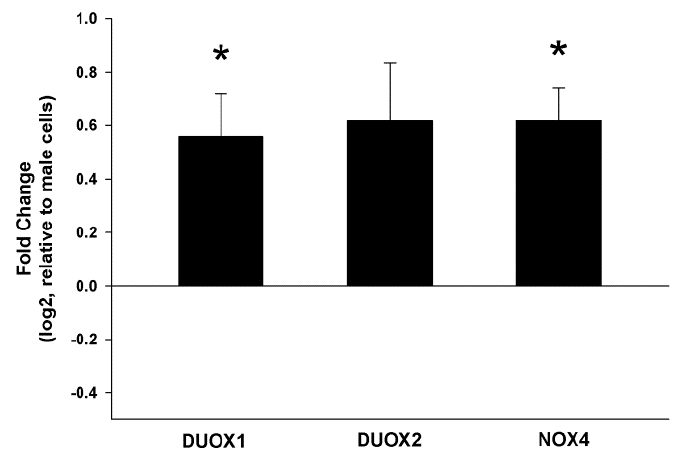
Figure 1. Expression (log2 fold change) of DUOX1, DUOX2 and NOX4 in cells derived from female rat thyroid relative to expression of these genes in cells derived from male rat thyroid. mRNA expression was determined by real-time PCR. Bars represent the mean ± SE of three independent experiments. * p < 0.05.